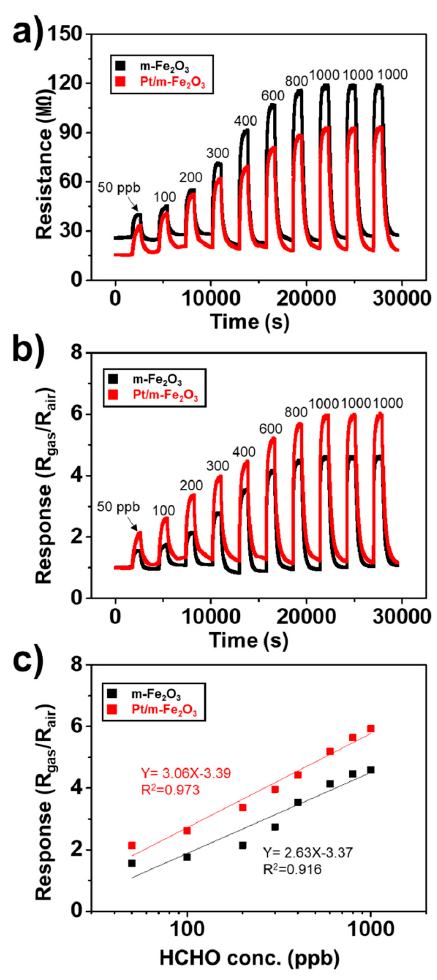
Figure 4. ( a ) Dynamic resistance changes in m-Fe 2 O 3 and 0.2% Pt/m-Fe 2 O 3 ; ( b ) response of m-Fe 2 O 3 and 0.2% Pt/m-Fe 2 O 3 ; and ( c ) linear fit between the response and log-scale HCHO concentration from 50 to 1000 ppb of m-Fe 2 O 3 and 0.2% Pt-Fe 2 O 3 at 275 °C.